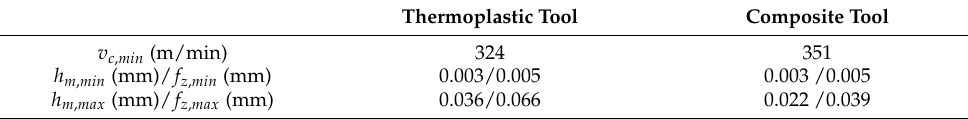
Table 6. Main cutting parameter limits of the thermoplastic and composite